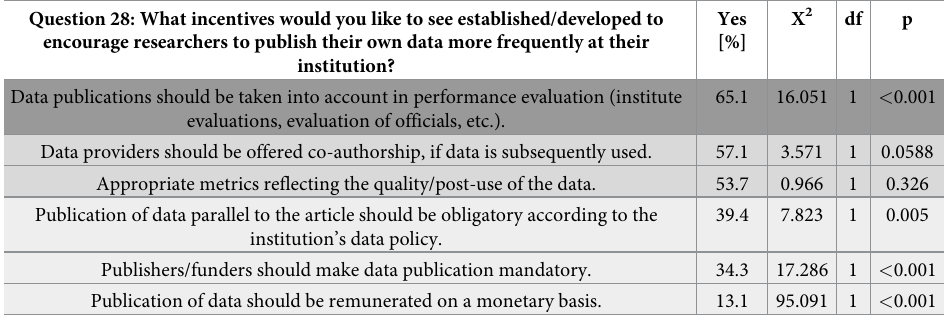
Yes X 2 df p [%] 65.1 16.051 1 < 0.001